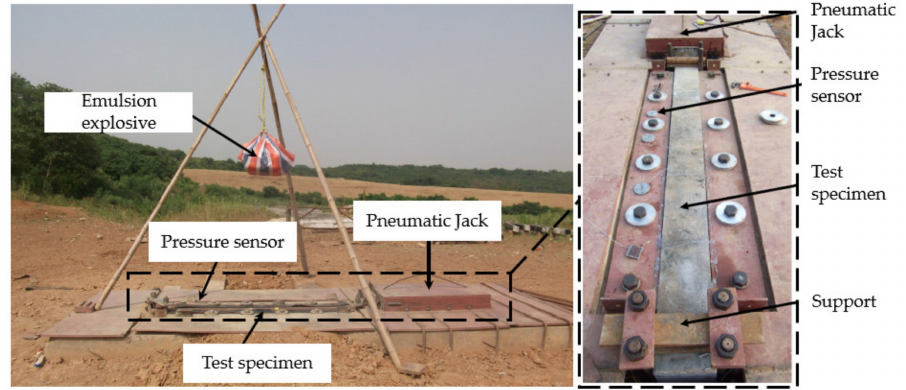
Figure 8. Test setup [24] and test pit [21]. Copyright permission obtained from authors.